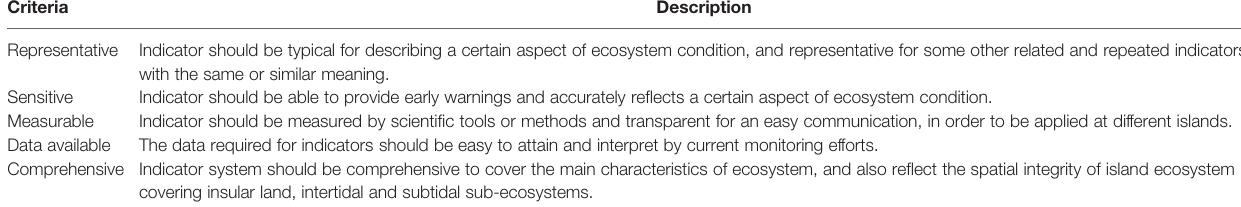
TABLE 2 | Criteria for selecting indicators of island ecosystem condition. Criteria